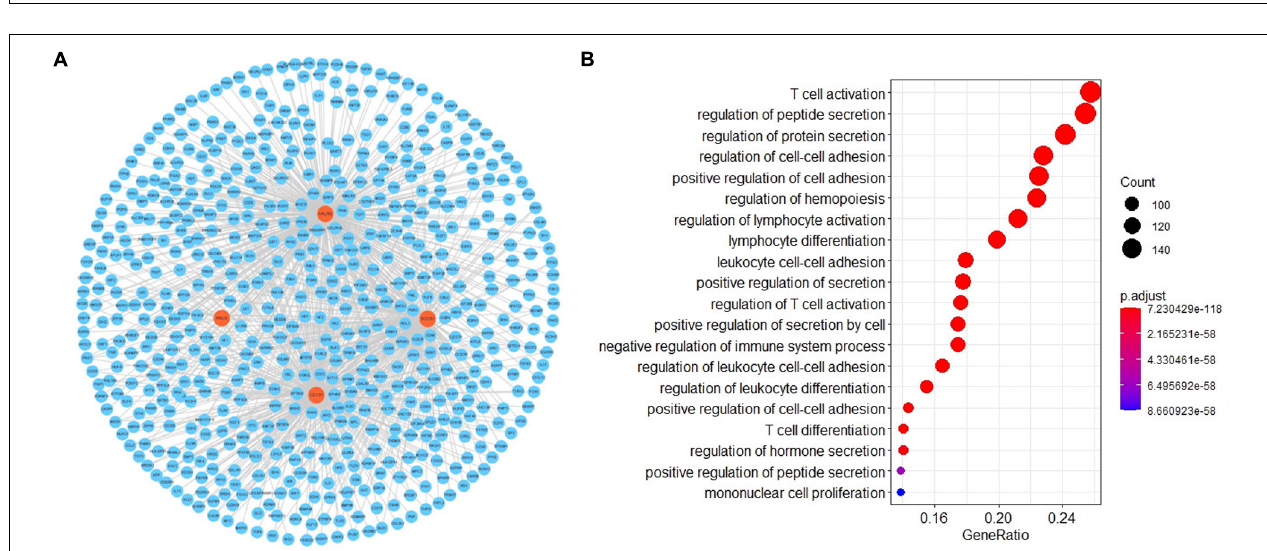
FIGURE 2 | IS (A) , atherothrombosis subtype of IS (B) , lacunar subtype of IS (C) , combination subtype of IS (D) results from MDR analysis. (a) interaction graph, for each SNP is reported in per cent the value of Information Gain (IG), while numbers in the connections indicate the entropy-based IG for the SNP pairs. Red bar and orange bar indicate the high-level synergies on the phenotype, while the brown indicate a medium-level interaction, green and blue connections with negative IG values indicate redundancy or lack of synergistic interactions between the markers. (b) shows the interaction dendrogram. Histograms in (c) reports the distributions of controls (left bars) and cases (right bars) genotype combinations of SNP. Dark-shaded cells are considered “high-risk” while light-shaded cells are considered “low risk.” White cells indicate no subjects with those genotype combinations that were observed in the data set.